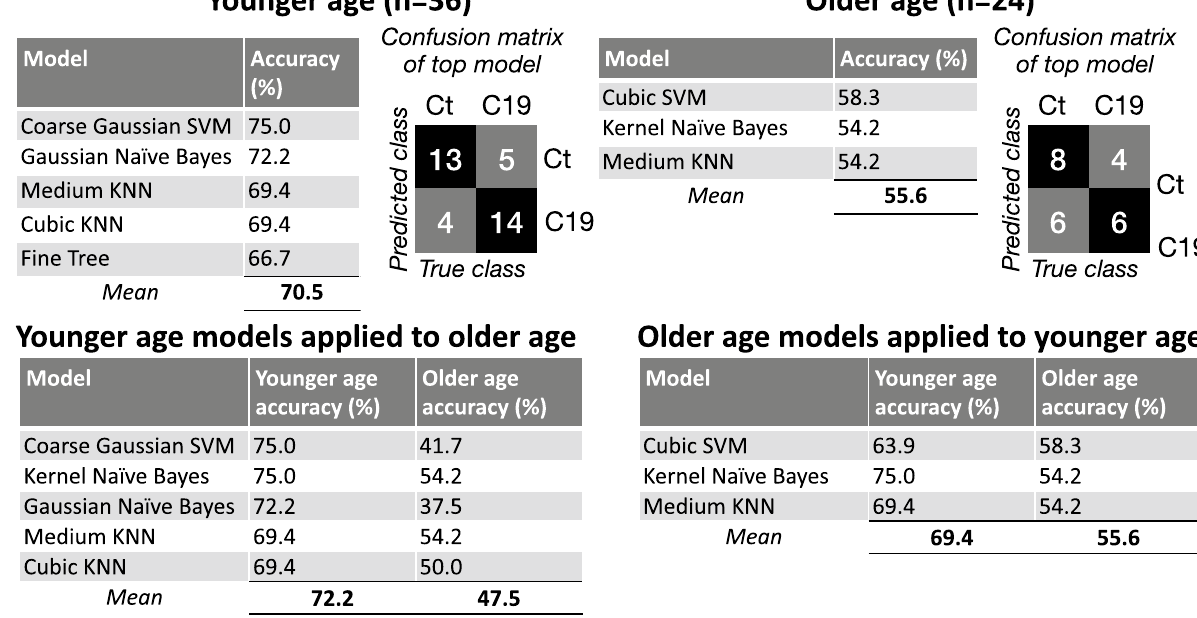
Table 3. (Upper row) Accuracy results of machine learning algorithms trained on EEG power features selected based on statistical tests performed in Figs. 1 and 4 (for example in Fig. 1 mean delta, theta, alpha and beta for younger subjects, and theta, beta and gamma for older subjects). (Bottom row) Feature sets used to train algorithms in a given group were applied to the other group for direct comparison. Only models with accuracy > 50% are